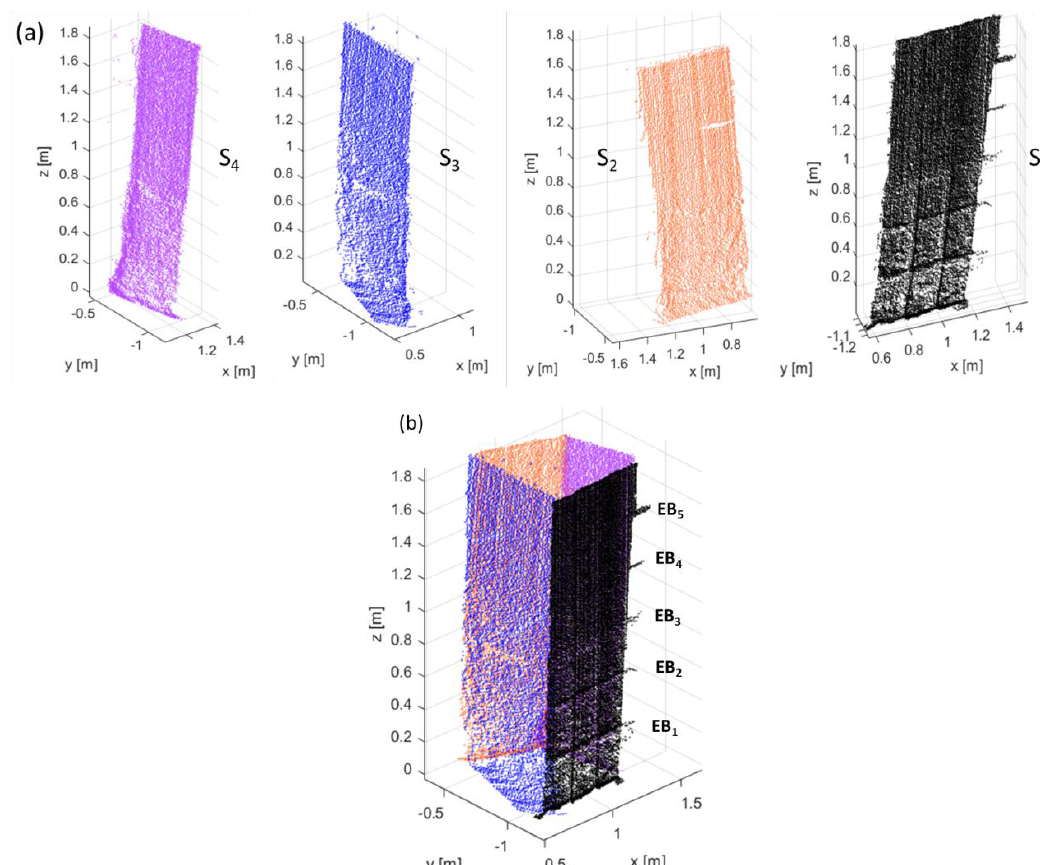
Figure 2. ( a ) Reconstruction of the four sides from the metal box. S 3 and S 4 are the sides parallel to the y axis, while S 1 and S 2 are the sides parallel to the x axis. ( b ) The resulting merged point cloud after registration and alignment of the four sides of the metal box.